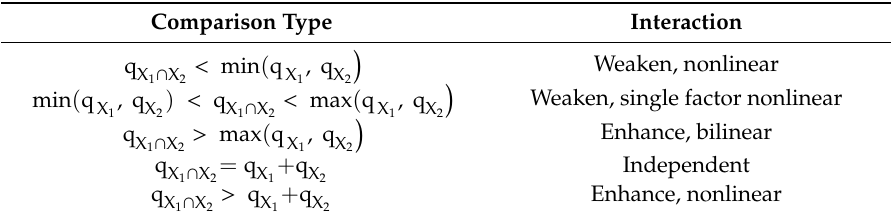
Table 5. Interaction derivation [9].